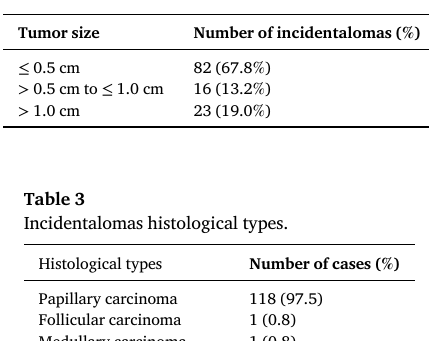
Table 2 Size of incidentalomas.